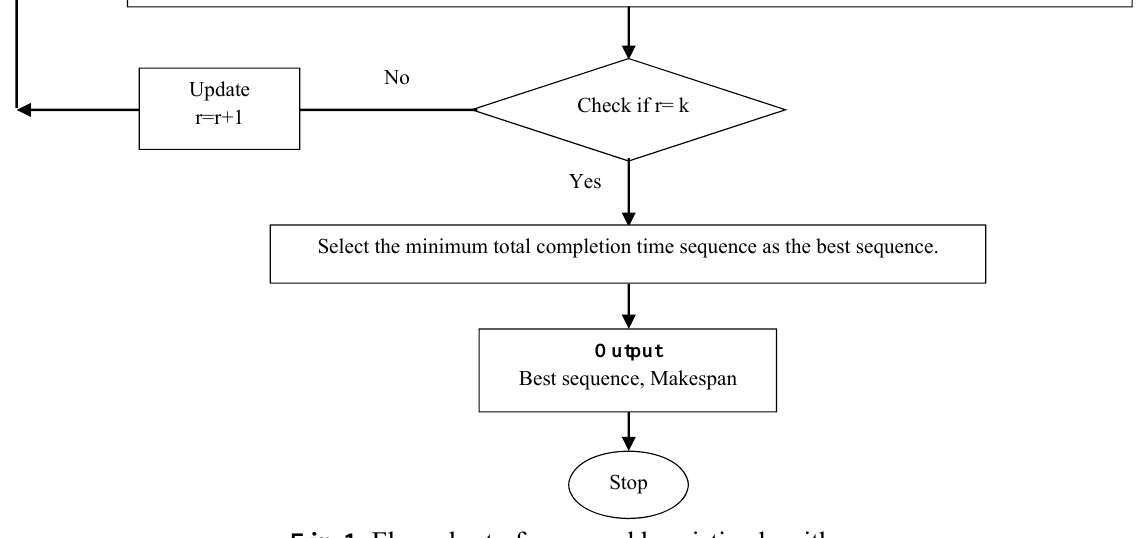
Fig. 1. Flow chart of proposed heuristic